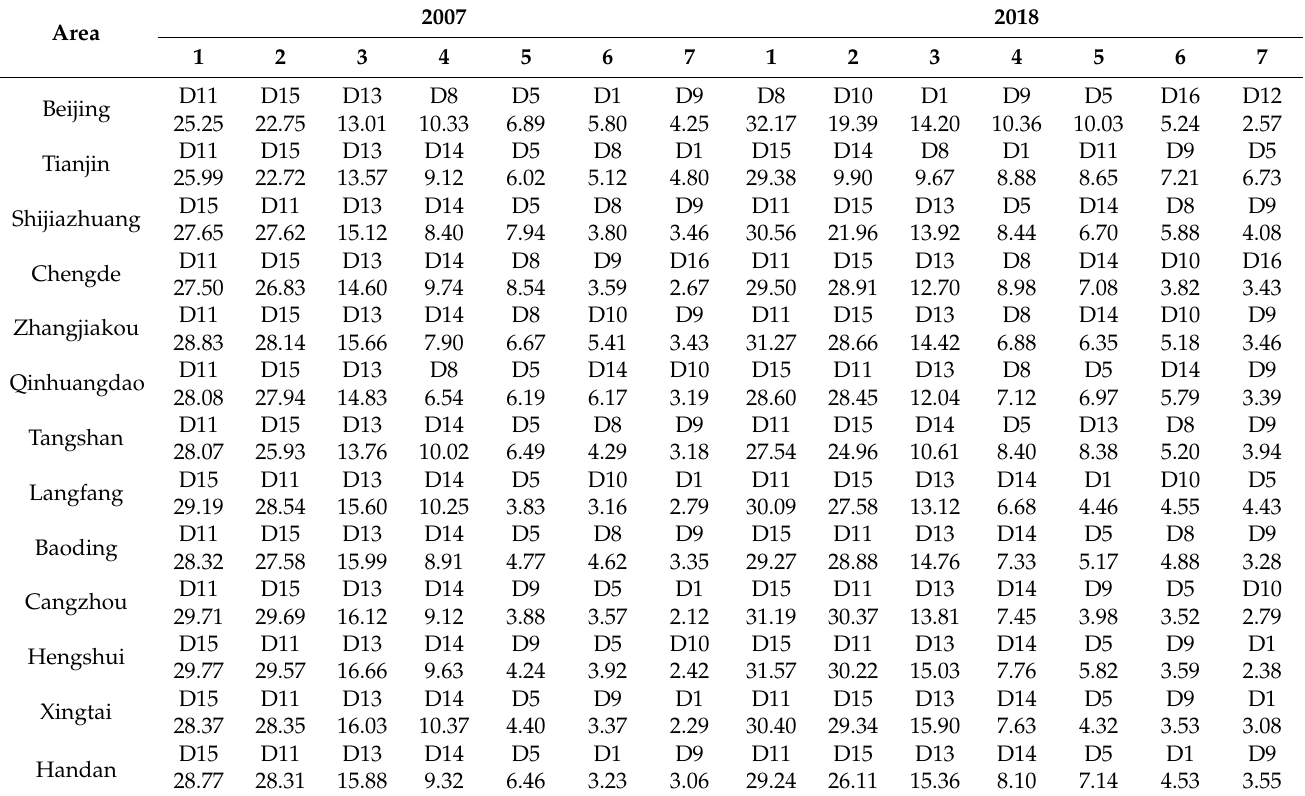
Table 6. Main obstacle indicators of LES in different areas of the BTH region in 2007 and 2018 (%).